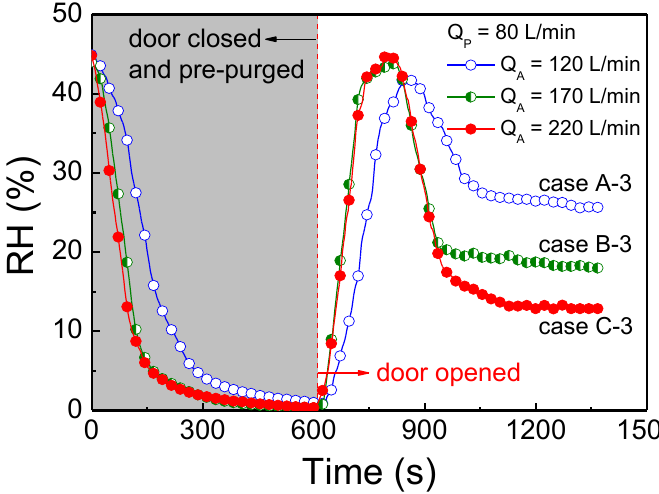
Figure 9. RH evolutions as function of CDA flow rate to air curtain at given CDA flow rate of 80 L/min to panel-purge system.